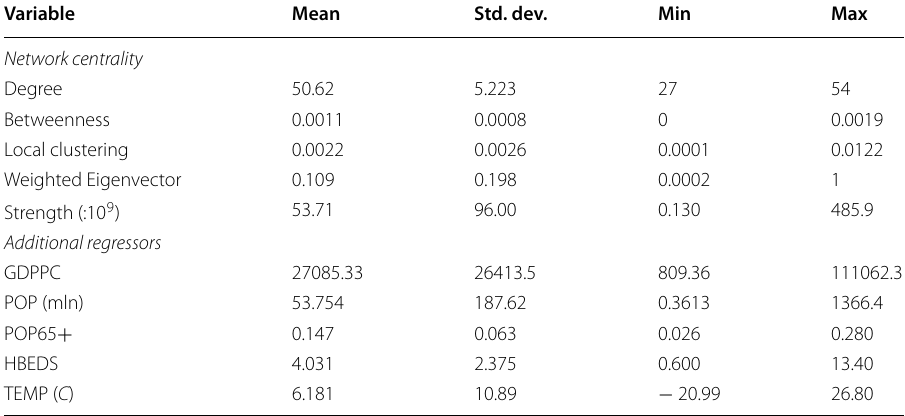
Table 2 Summary statistics referred to 2019